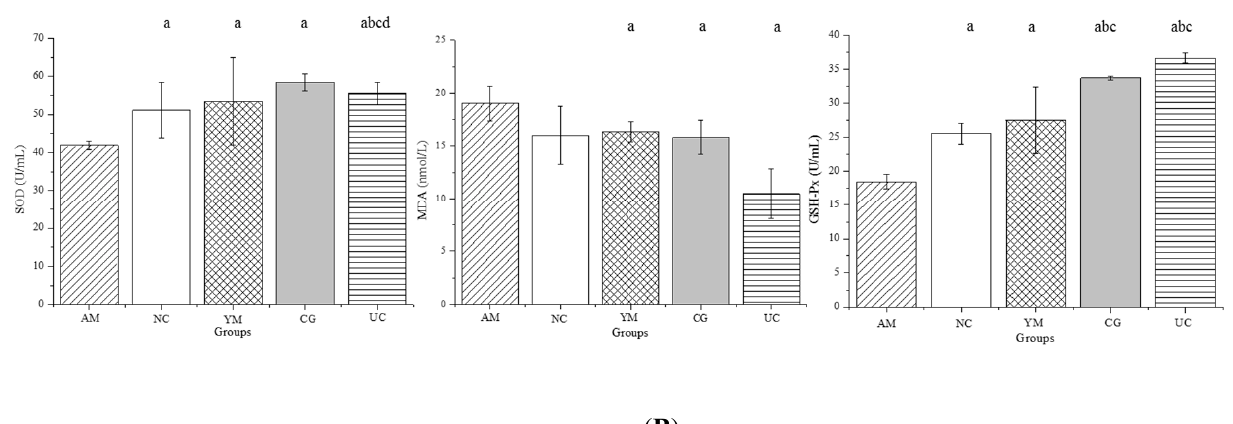
Figure 4. Serum levels of inflammatory cytokines and oxidative stress in the five groups. ( A ) Serum levels of inflammatory cytokines including IL-1 β , IL-6, and TNF- α ; ( B ) serum levels of oxidative stress indexes including MDA, SOD, and GSH-Px. Serum data are expressed as the means ± SD ( n = 5, 7, 9, 9, and 10 in the AM, CG, UC, NC, and YM groups); a p < 0.05 versus the AM group, b p < 0.05 versus the NC group, c p < 0.05 versus the YM group, d p < 0.05 versus the CG group.